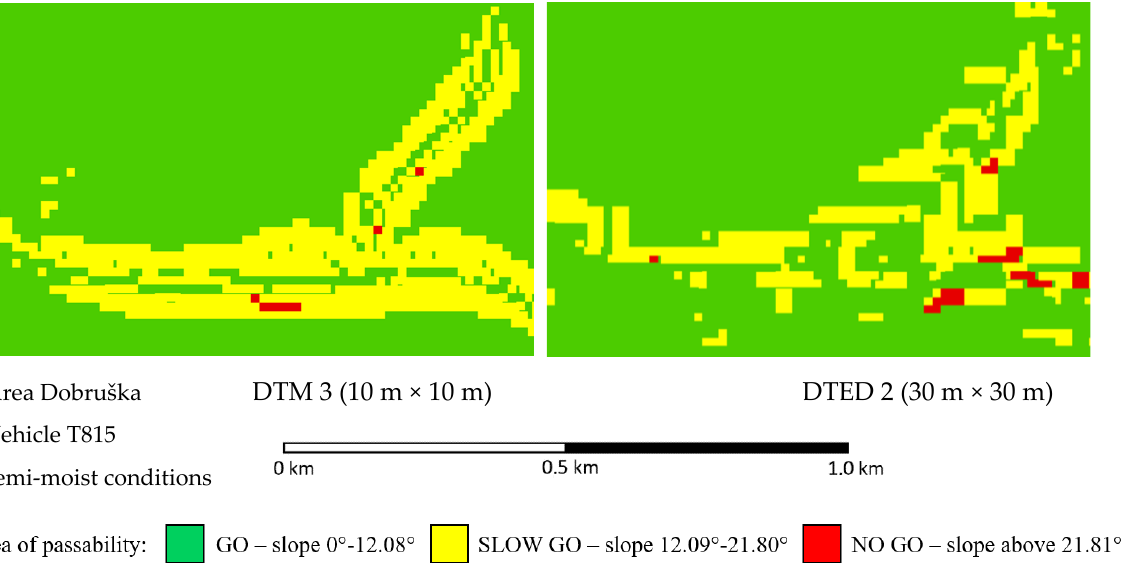
Figure 8. The result of the cross-country mobility analysis of a selected locality for the vehicle T815. A detailed look at a selected valley in the Dobruška locality. Testing was done with the method of raster analysis of the evaluation of pixels for various DEMs (DTM 5, DTM 4, DTM 3, DTED 2). Table 4. Average deviations of the passable area calculated from elevation models (DTM 4, DTM 3, DTED 2) in comparison with DTM 5 with different parameters (vehicle type, humidity); results are mean values for five 3 km × 3 km areas, max–maximum available slope for the respective conditions, 1% deviation of the area means 9 hectares out of 900 hectares of one area and area deviations of elevation models with DTM 5 are always positive (larger passable